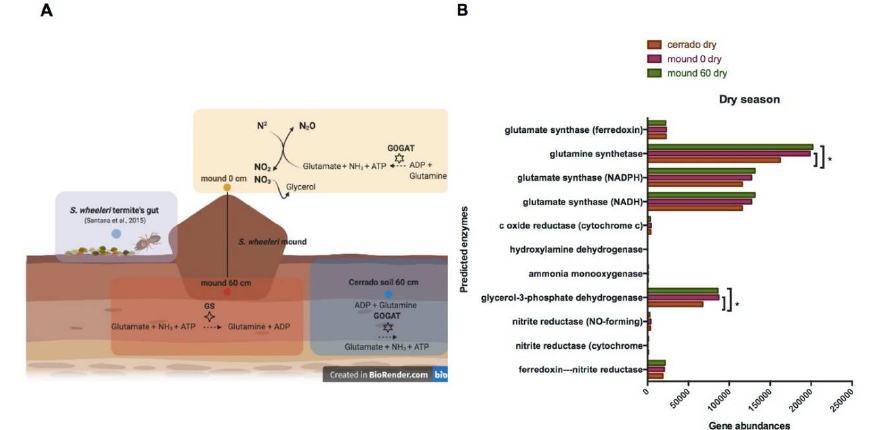
Figure 7. Termite mound soil in the dry season. ( A ) mound samples are shown in orange (0 cm, surface) and red (60 cm depth), and the Cerrado soil samples are in blue in the dry season. The enzymatic reactions that possibly occur in greater abundance at the surface are: nitrogen metabolism—from its fixation until nitrite, nitrate, and glycerol production and the GOGAT pathway. The reverse reaction for glutamine production via GS pathway occurs in greater abundance in the mound 60 cm samples, whereas this pathway is directed to glutamate production in the Cerrado samples via